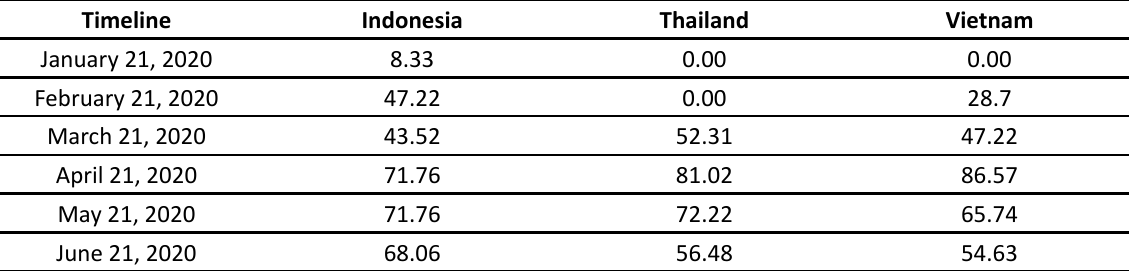
Table 2: The Government Response Stringency on COVID-19 Timeline